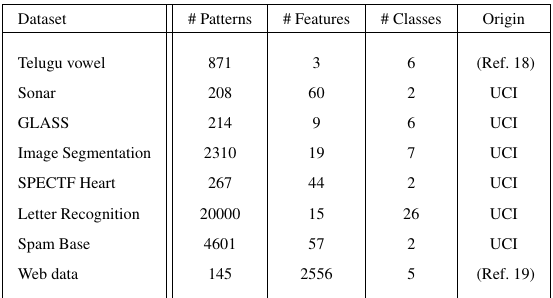
Table 1. Data set